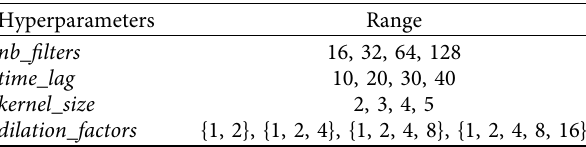
Figure 9: Recombined subsequences of (a) 717490 and (b) 718462. Table 3: TCN